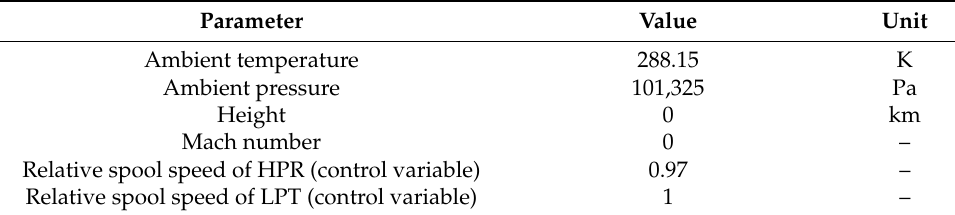
Table 2. The ambient conditions, working conditions, and control variables. Parameter Value Unit Ambient temperature 288.15 K Ambient pressure 101,325 Pa Height 0 km Mach number 0 – Relative spool speed of HPR (control variable) 0.97 – Relative spool speed of LPT (control variable) 1